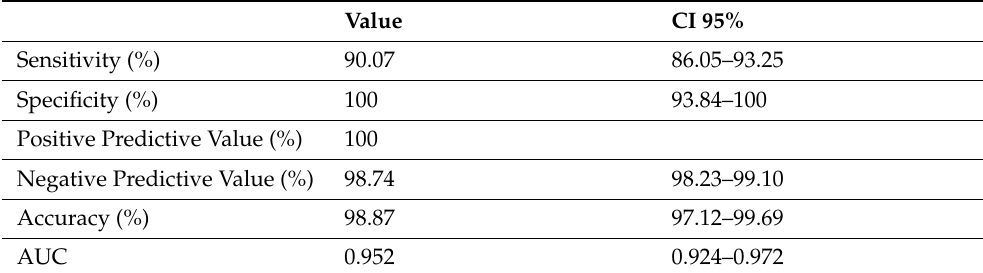
Table 4. Sensitivity, specificity, predictive values, and diagnostic